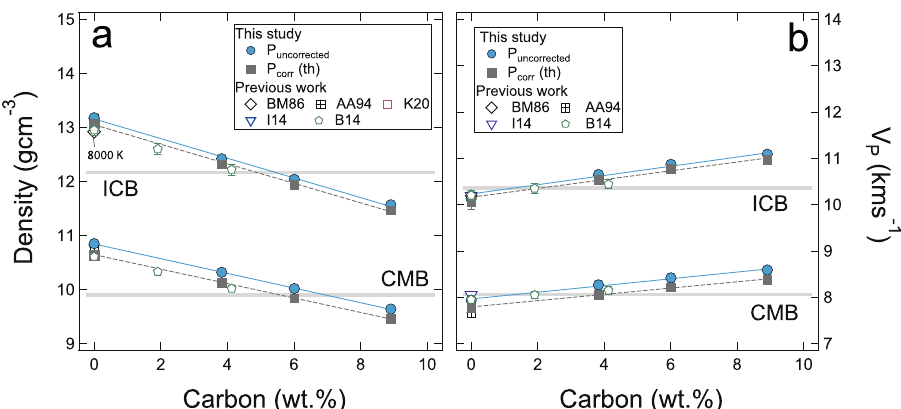
Fig. 3 Effect of carbon on the density ( ρ ) and compressional wave velocity ð V P Þ of liquid iron. Ch a nge in ( a ) ρ and ( b ) V P of liquid Fe as a function of carbon content at core – mantle boundary (CMB: 136 GPa, 4400K) and inner-core boundary (ICB: 330 GPa, 6000 K) conditions. Results for the metallic melts are from previous experimental studies, AA94, BM86, K20 106 – 108 and FPMD studies, B14, I14 6,58 . Lines show the linear relationship of ρ and V P with the increasing amount of carbon (in wt.%). Filled gray squares represent the results after applying the thermodynamic pressure correction ( P th ) corr (Supplementary Note S1). When the pressure is adjusted using P th , the wt.% of carbon required to satisfy the seismic ρ and V P becomes lower and higher, corr respectively. Error bars represent ±1 σ